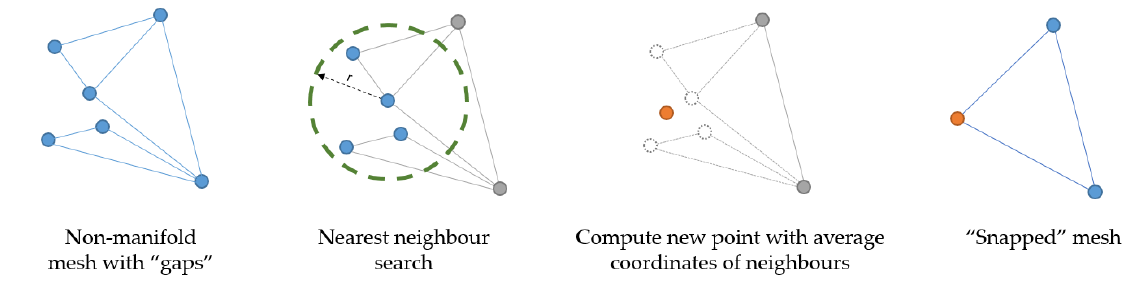
Figure 2. General illustration of the developed approach to extract roof 3D primitives from the input UAV images-derived point